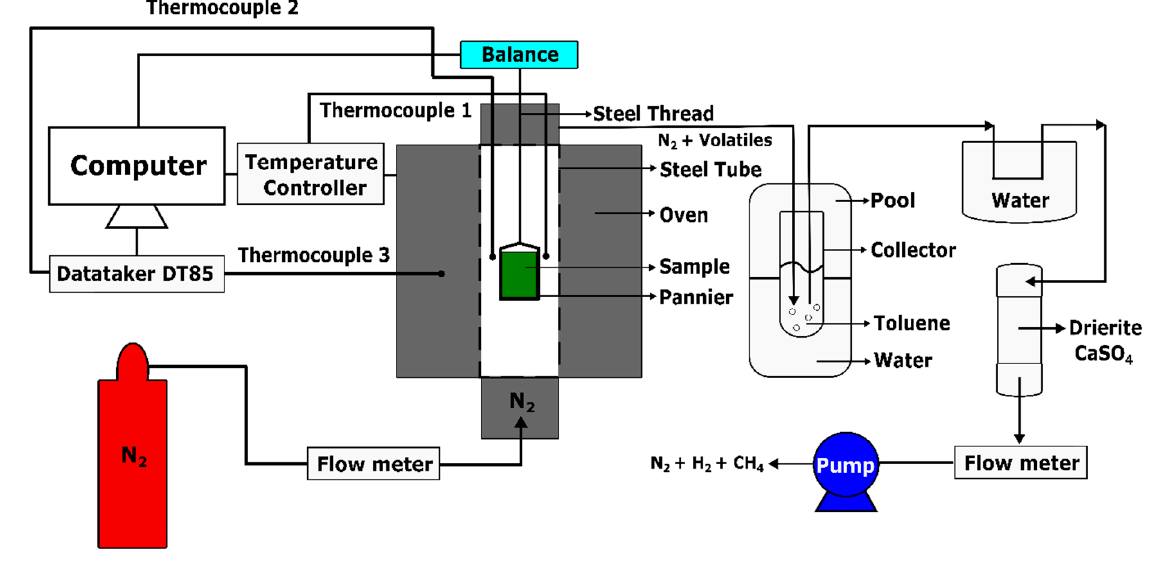
Figure 4. Schematic representation of TGA set-up.